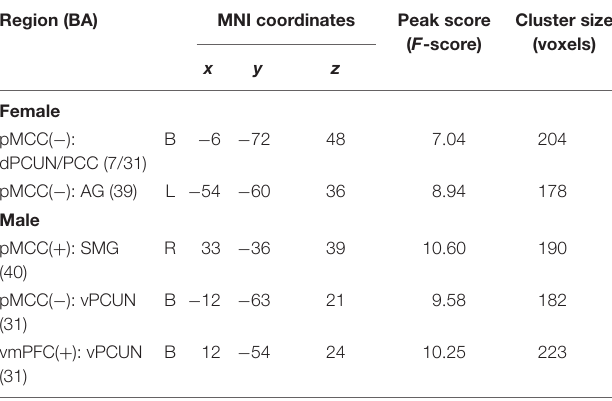
TABLE 2 | Regions showing the age effect on the functional connectivity for the pMCC networks in the females and males. Region (BA) MNI coordinates Peak score